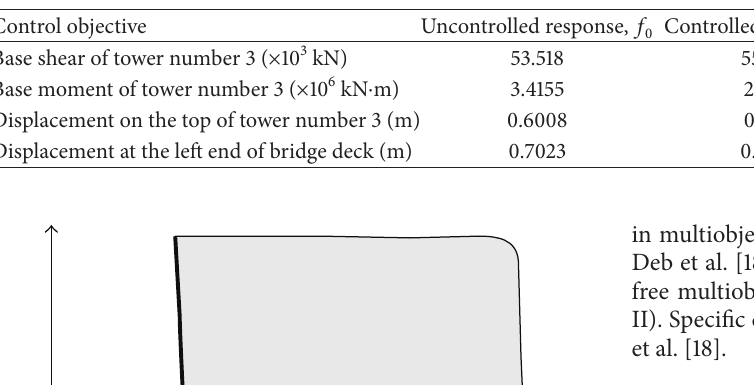
Table 2: Seismic control effects of the multitower cable-stayed bridge with the fully floating system.